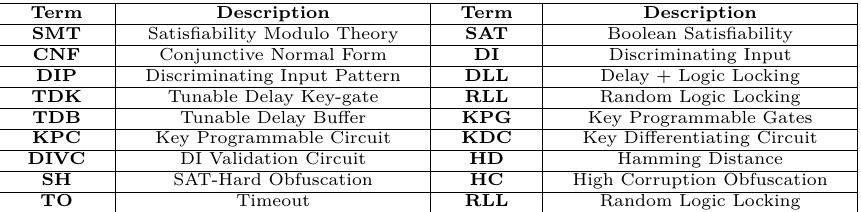
Table 1: List of Abbreviations Frequently used in this Paper. Term Description Term Description SMT Satisfiability Modulo Theory SAT Boolean Satisfiability CNF Conjunctive Normal Form DI Discriminating Input DIP Discriminating Input Pattern DLL Delay + Logic Locking TDK Tunable Delay Key-gate RLL Random Logic Locking TDB Tunable Delay Buffer